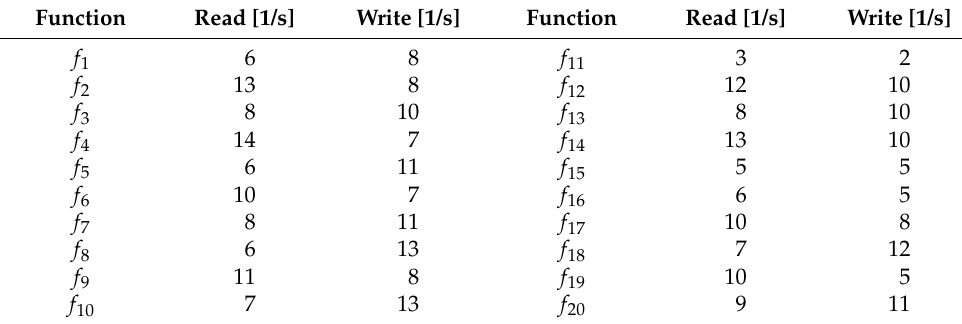
Table 2. Read and write intensities of functions in the experimental